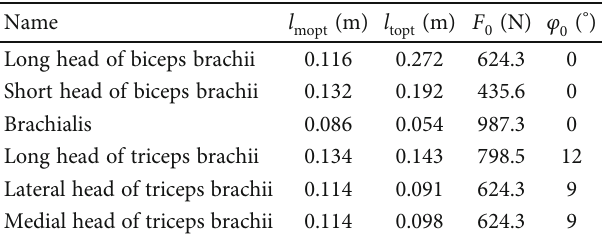
Table 2: Relevant personalized parameters used in this paper.